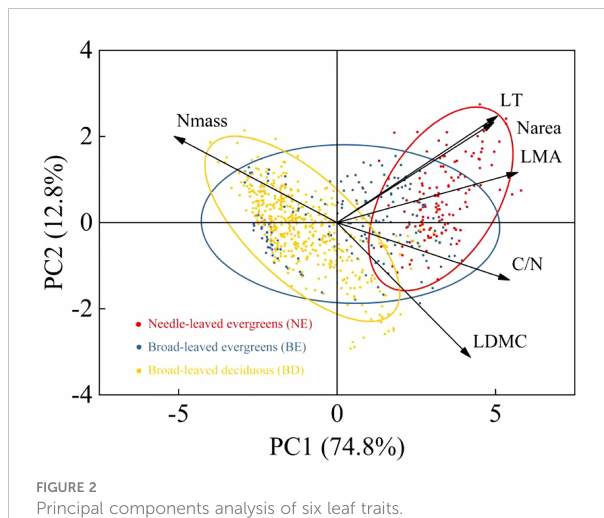
FIGURE 2 Principal components analysis of six leaf